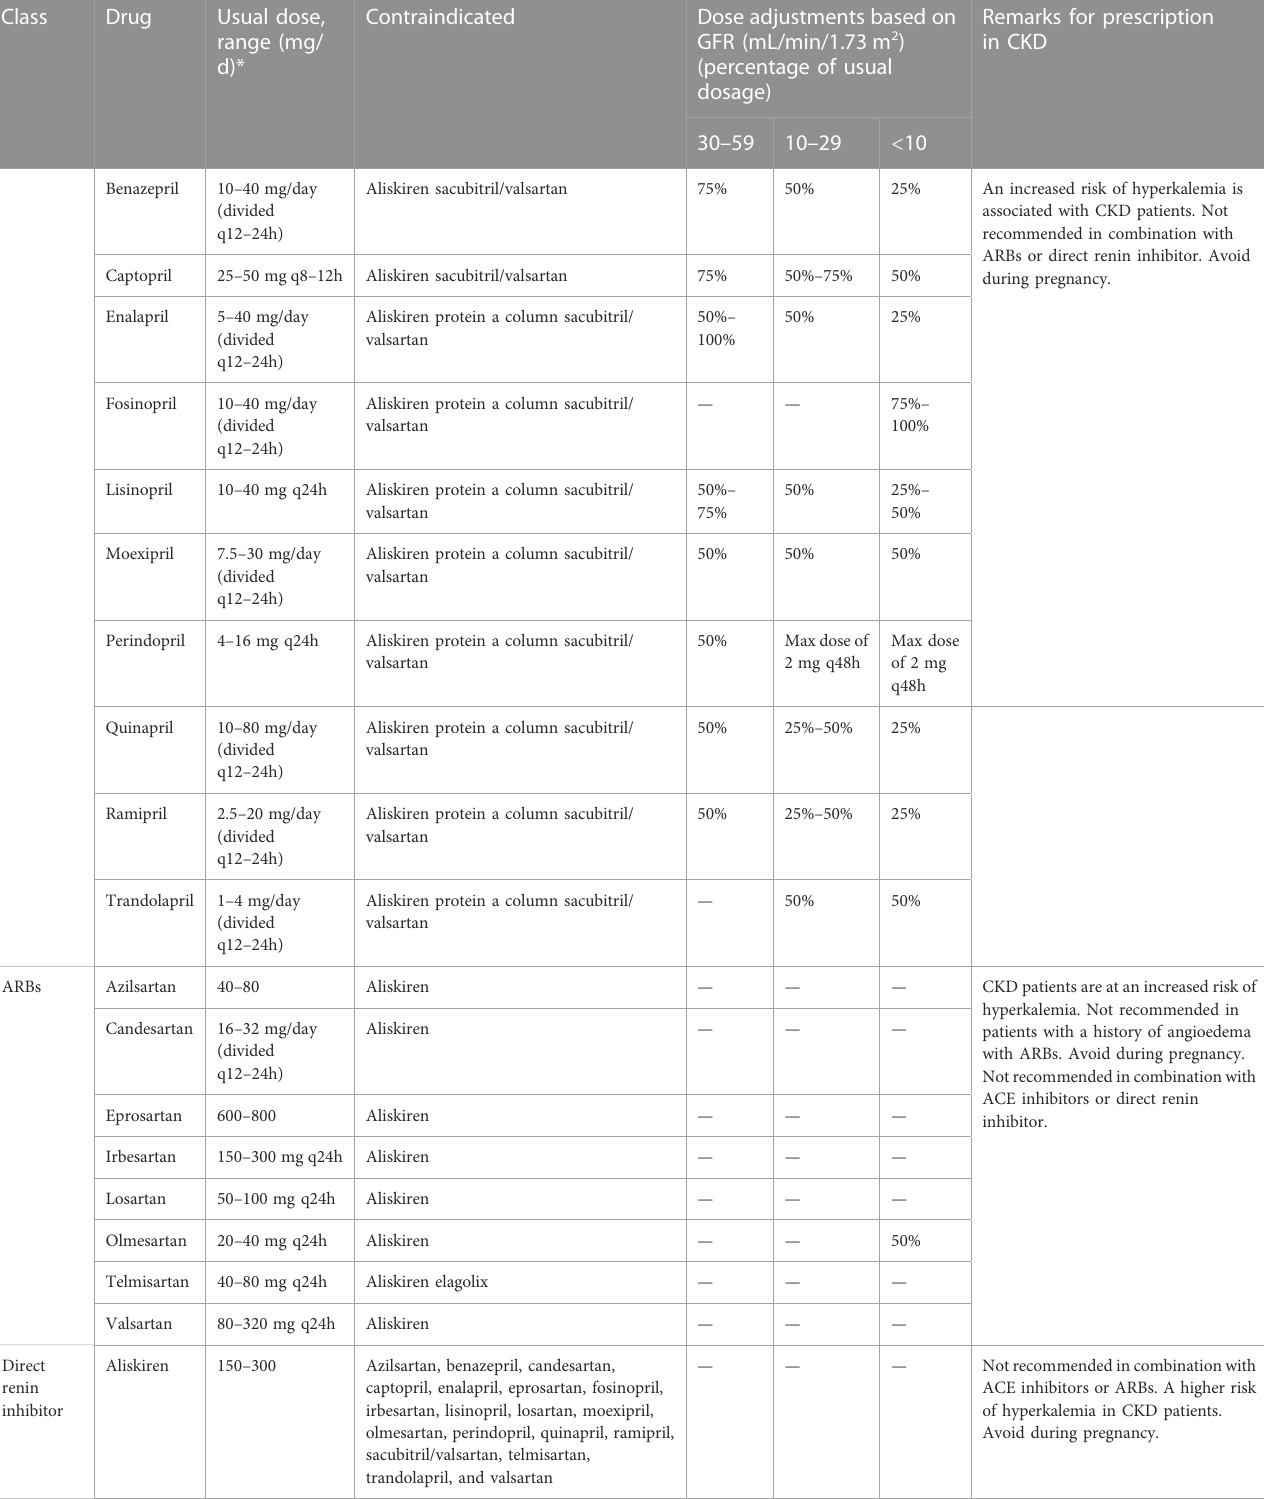
TABLE 4 Agents for renin – angiotensin – aldosterone blockade, their doses, contraindicated drugs, and dosage modi fi cation in CKD. Class